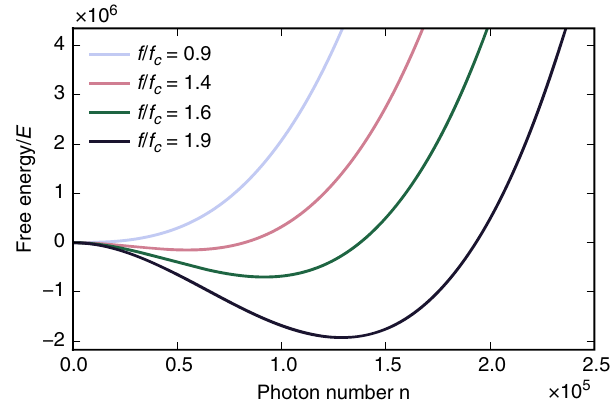
Fig. 8 Effective free-energy landscapes. Free energy for the microcavity photon number (order parameter), calculated for different values of the initial molecular excitation fraction f . Besides being the quantity directly varied in the experiment, f determines the control parameter as N ex = n + fN mol